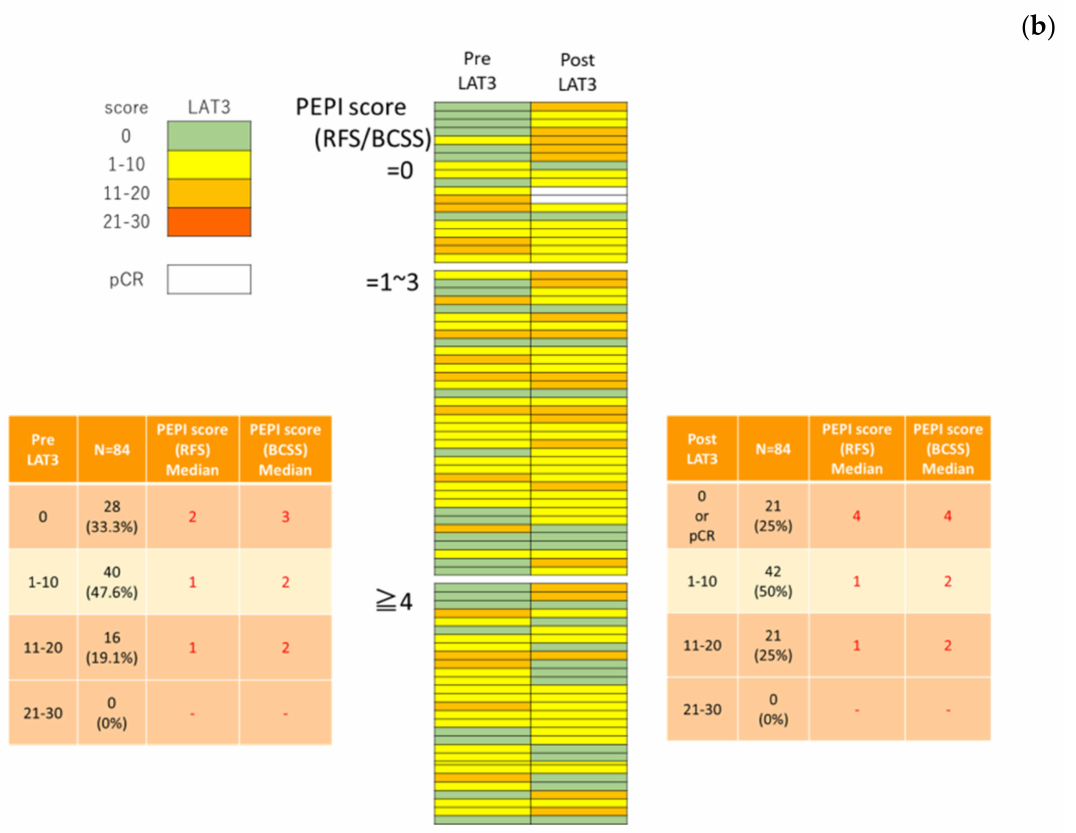
Figure 3. Change of LAT1 ( a ) and LAT3 ( b ) expression tentatively categorized according to PEPI score.